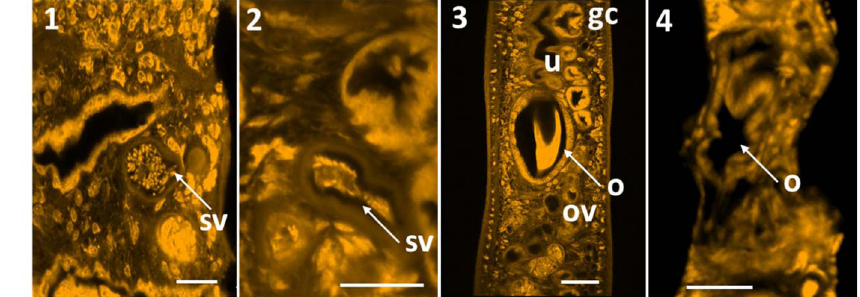
Fig. 4 Post-challenge phase between Wk0pc (Wk42 post-infection) and Wk20pc (Wk62 post-infection). a Estimation of challenge worm burden using circulating anodic antigen (CAA) values on the primary y-axis and predicted adult worm equivalents on the secondary y-axis, calculated from ref. 43 . On the left panels, the four individual Fast responder animals, on the right are the four Slow responders and in the centre the pro fi le for the two intermediate responders and Rh1. Source data are provided as a Source Data fi le. b Confocal micrographs of male (1, 2) and female worms (3, 4) recovered from permissive mice (1, 3), and from rhesus macaques (2, 4) at Week 20 post-challenge. The seminal vesicle (sv) in the male worm from a mouse is full of individual stumpy spermatozoa (1) whilst that in the worm from rhesus (2) contains a compacted aggregated mass of material. The ootype (o) in the female worm from mouse (3) contains a tanned protein eggshell while the ootype in the shrunken female from rhesus (4) is empty. gc gut caecum, u uterus, ov oviduct. Magni fi cation bars all at 20 μ m indicate the shrunken size of the female worm from rhesus. Each recovered worm was prepared by staining in Langeron ’ s Carmine, followed by dehydration, and mounting on one microscope slide. Several micrographs were obtained for each worm, and representative images are Elevated granulocyte and lymphocyte populations accom- anti-SWAP response fell sharply to a level below, but not sig- panying self-cure were not observed after the challenge . The ni fi cantly different from, the primary response (Fig. 5h); by Wk16pc it was very signi fi cantly lower than after the primary haematological changes did not segregate by Fast and Slow infection ( P < 0.001). The anti-SSP response detected by the Slow responders, so all data were analysed as a single group. Mean pool peaked at Wk8pc but then declined rapidly out to Wk20pc, haematocrit at Wk0 was 40%, declining to 35.3% by Wk12, a while the Fast pool reached baseline by Wk16pc (Fig. 5f). reduction of ~11% ( P < 0.05; Fig. 6a). It had returned to normal